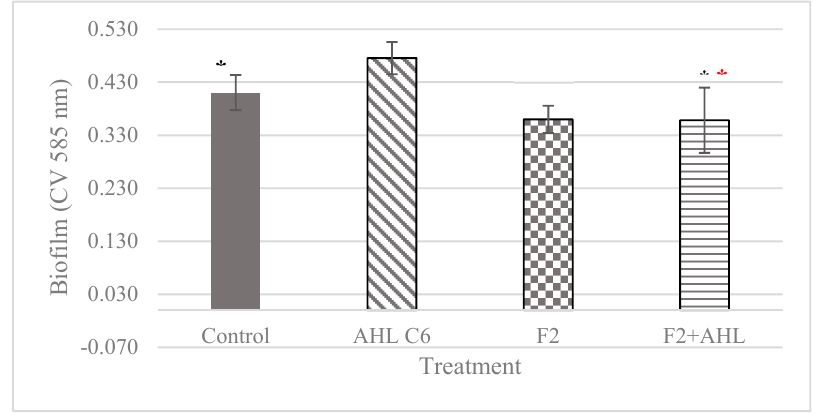
Figure 9. The neutralizing effect of C6-AHL autoinducer with 3-methyl-2(5H)-furanone (G2). The biofilm was formed for 30 h at 37 °C with the addition of the compounds from the beginning of the assay. The biofilm was quantified by staining with violet crystal. The black asterisks indicate statistically significant difference to the control, whereas the red asterisks indicate statistically significant difference as compared to C6-AHL.